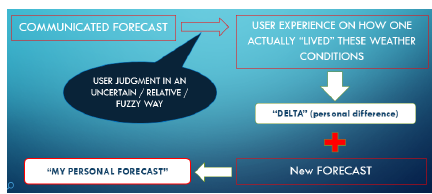
Figure 2. Schematic of the research idea: The co-creation process of “MY PERSONAL